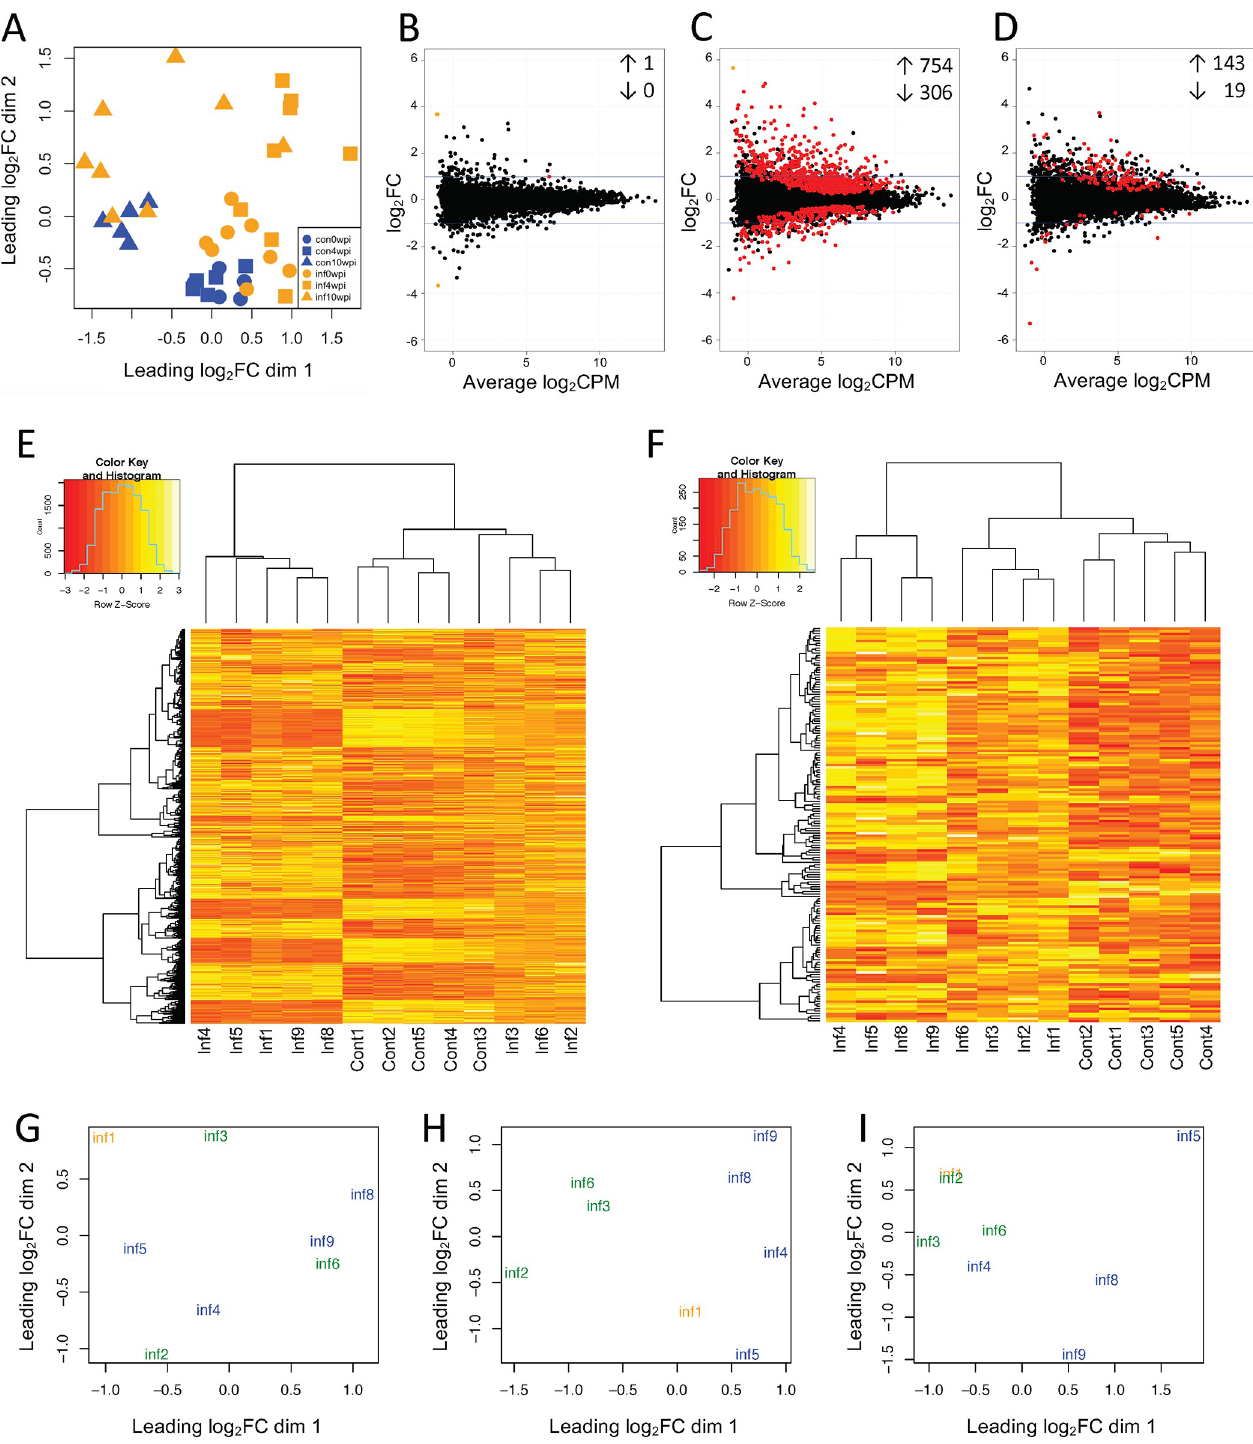
Fig 2. Differential gene expression observed between M . bovis -infected and uninfected cattle revealed two transcriptional clusters of infected animals. Whole blood from M . bovis experimentally infected (n = 8) and uninfected (n = 5) cattle at 0 wpi, 4 wpi, and 10 wpi was collected and analyzed for differential gene expression. (A) MDS plot of infected and uninfected samples at 0 wpi, 4 wpi, and 10 wpi based on the top 500 genes with highest standard deviations between treatment groups. Each point represents an individual sample, and smaller distances between points represent greater similarities. (B-D) Gene expression in infected compared to uninfected cattle at 0 wpi (B), 4 wpi (C), and 10 wpi (D). Positive logFC indicates genes with increased expression in infected samples, while negative logFC indicates genes with decreased expression in infected samples. Each point represents an individual gene. Red points